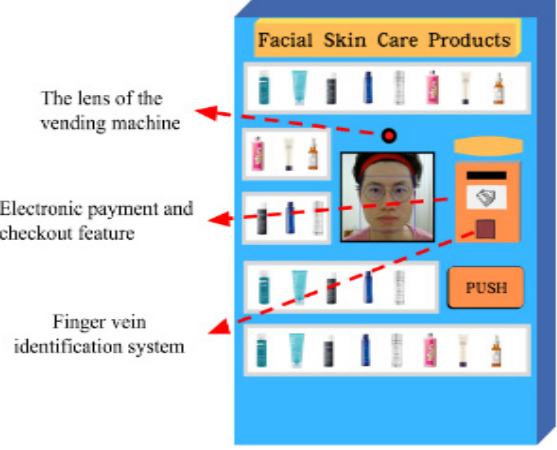
Figure 5. Schematic diagram of facial skincare products’ vending machine.